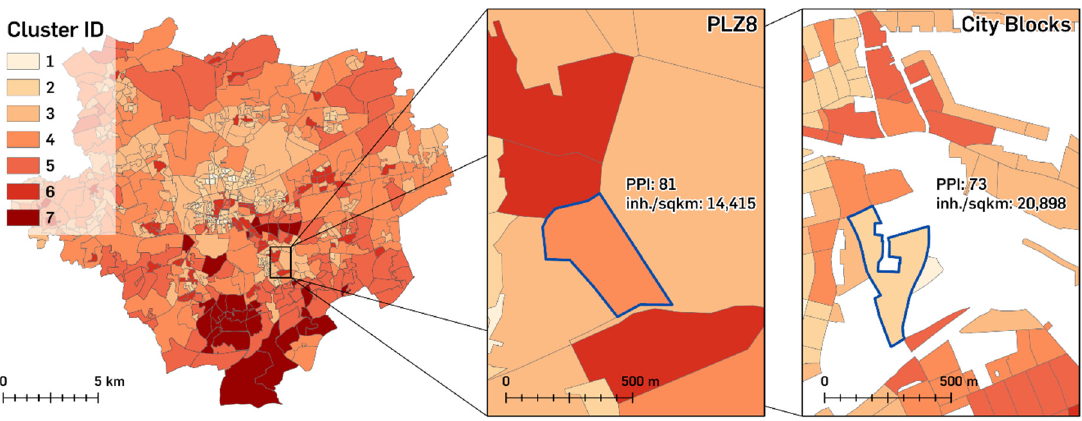
Figure 11. Clarenberg building complex (blue outline) in Dortmund—comparison of extent, shape, and values before and after disaggregation (Date source: [22,23,25,40]).